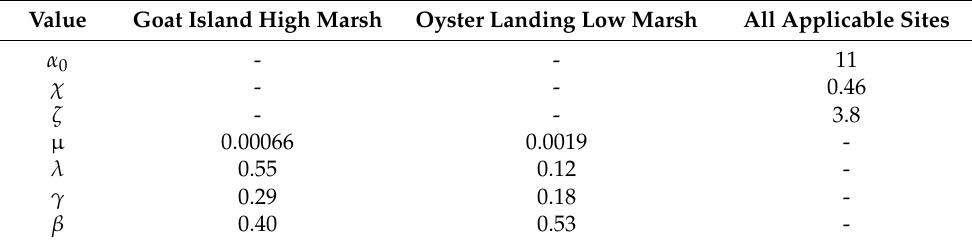
Table A1. Empirical coefficients used for calculating C D across